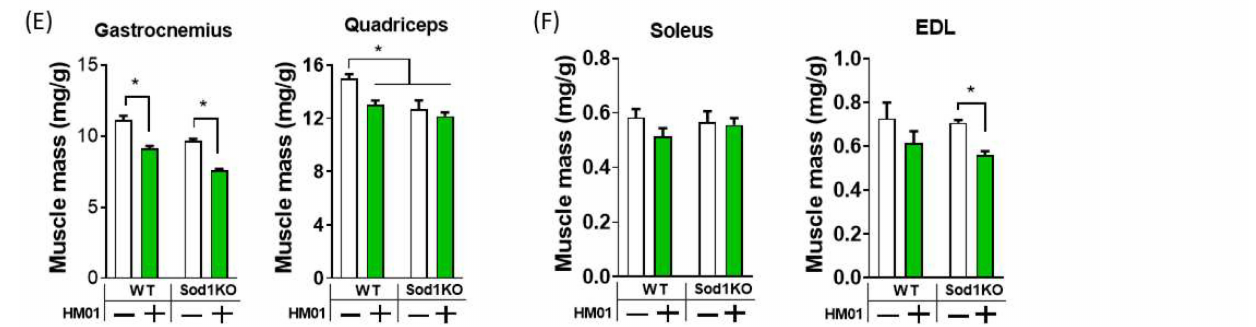
Figure 1. Four-week treatment of HM01 increases food intake transiently but decreases lean body mass and muscle mass. ( A ) Food consumption during the four-week HM01 treatment. ( B ) Percent body weight relative to initial over four-week study period. ( C , D ). % fat mass and % lean mass relative to body weight at study endpoint. ( E ) Gastrocnemius and quadriceps normalized to body weight. ( F ) Soleus and extensor digitorum longus normalized to body weight. Two-Way ANOVAs were used to test statistical significance between groups, followed by Tukey post hoc tests. Data are mean ± SEM. p < 0.05. * significant difference between WT and WT-HM01. # Significant difference between Sod1KO and Sod1KO-HM01. Abbreviation: +, treated; − , untreated; EDL, extensor digitorum